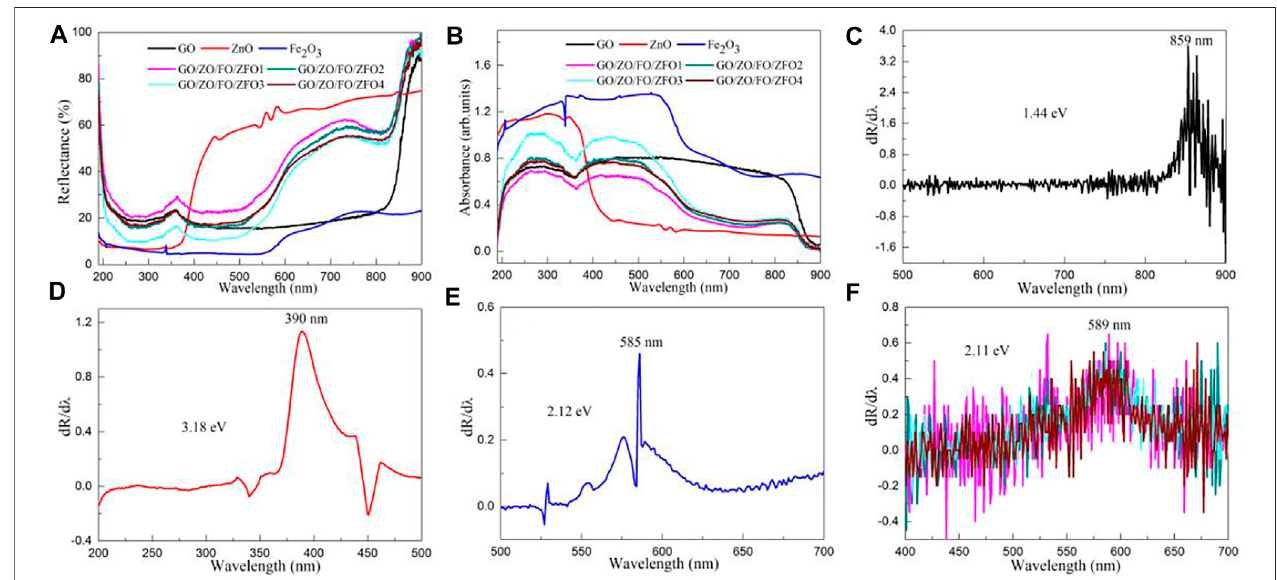
FIGURE 6 | (A) UV-Vis diffuse re fl ectance spectra and (B) UV-Vis absorption spectra of samples GO, ZnO, Fe 2 O 3 , GO/ZO/FO/ZFO1, GO/ZO/FO/ZFO2, GO/ZO/ FO/ZFO3, and GO/ZO/FO/ZFO4. First-order differential curves of UV-Vis diffuse re fl ectance spectra of samples (C) GO, (D) ZnO, (E) Fe 2 O 3 , (F) GO/ZO/FO/ZFO1, GO/ ZO/FO/ZFO2, GO/ZO/FO/ZFO3, and GO/ZO/FO/ZFO4.